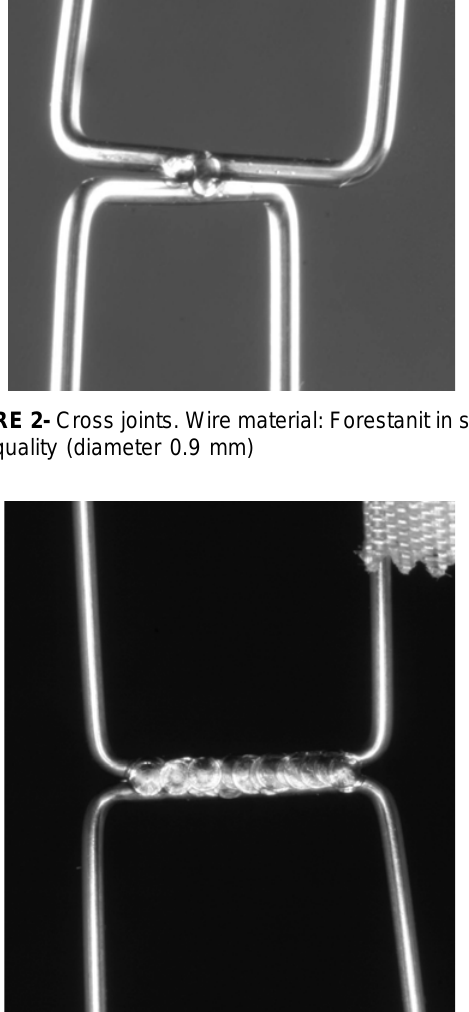
Figure 4- 9-mm long joints. Wire material: Forestanit in spring hard quality (diameter 0.9 mm)